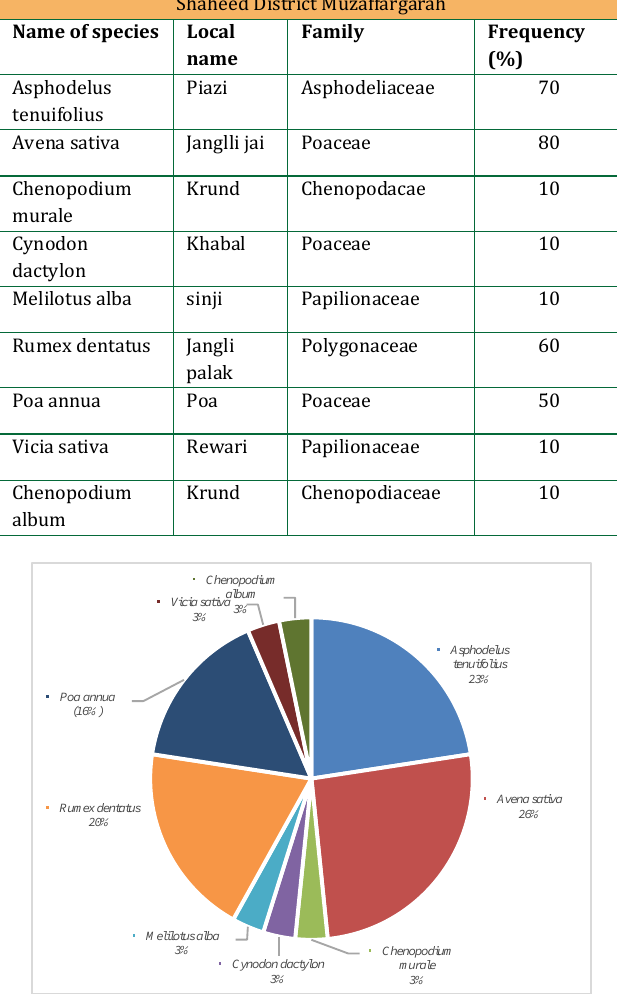
Table 7: Frequency (%) of weed infesting wheat field at chok Sarwar